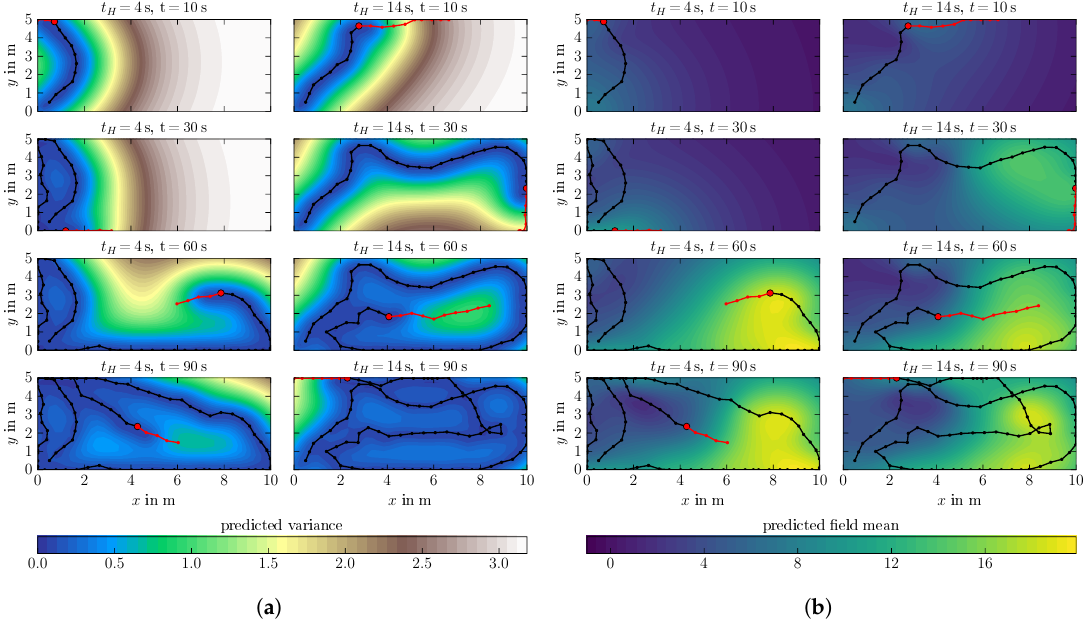
Figure 13. STKF algorithm exploration results for two time horizon lengths t H = 4 s and t H = 14 s and temporal length scale of 10 7 which results in a belief remaining almost constant with respect to time. The agent ( • ) moves along its trajectory ( | ) following an optimal path ( | ) by applying the first optimal control step. The optimal path is computed by PI 2 using the conditional variance of the